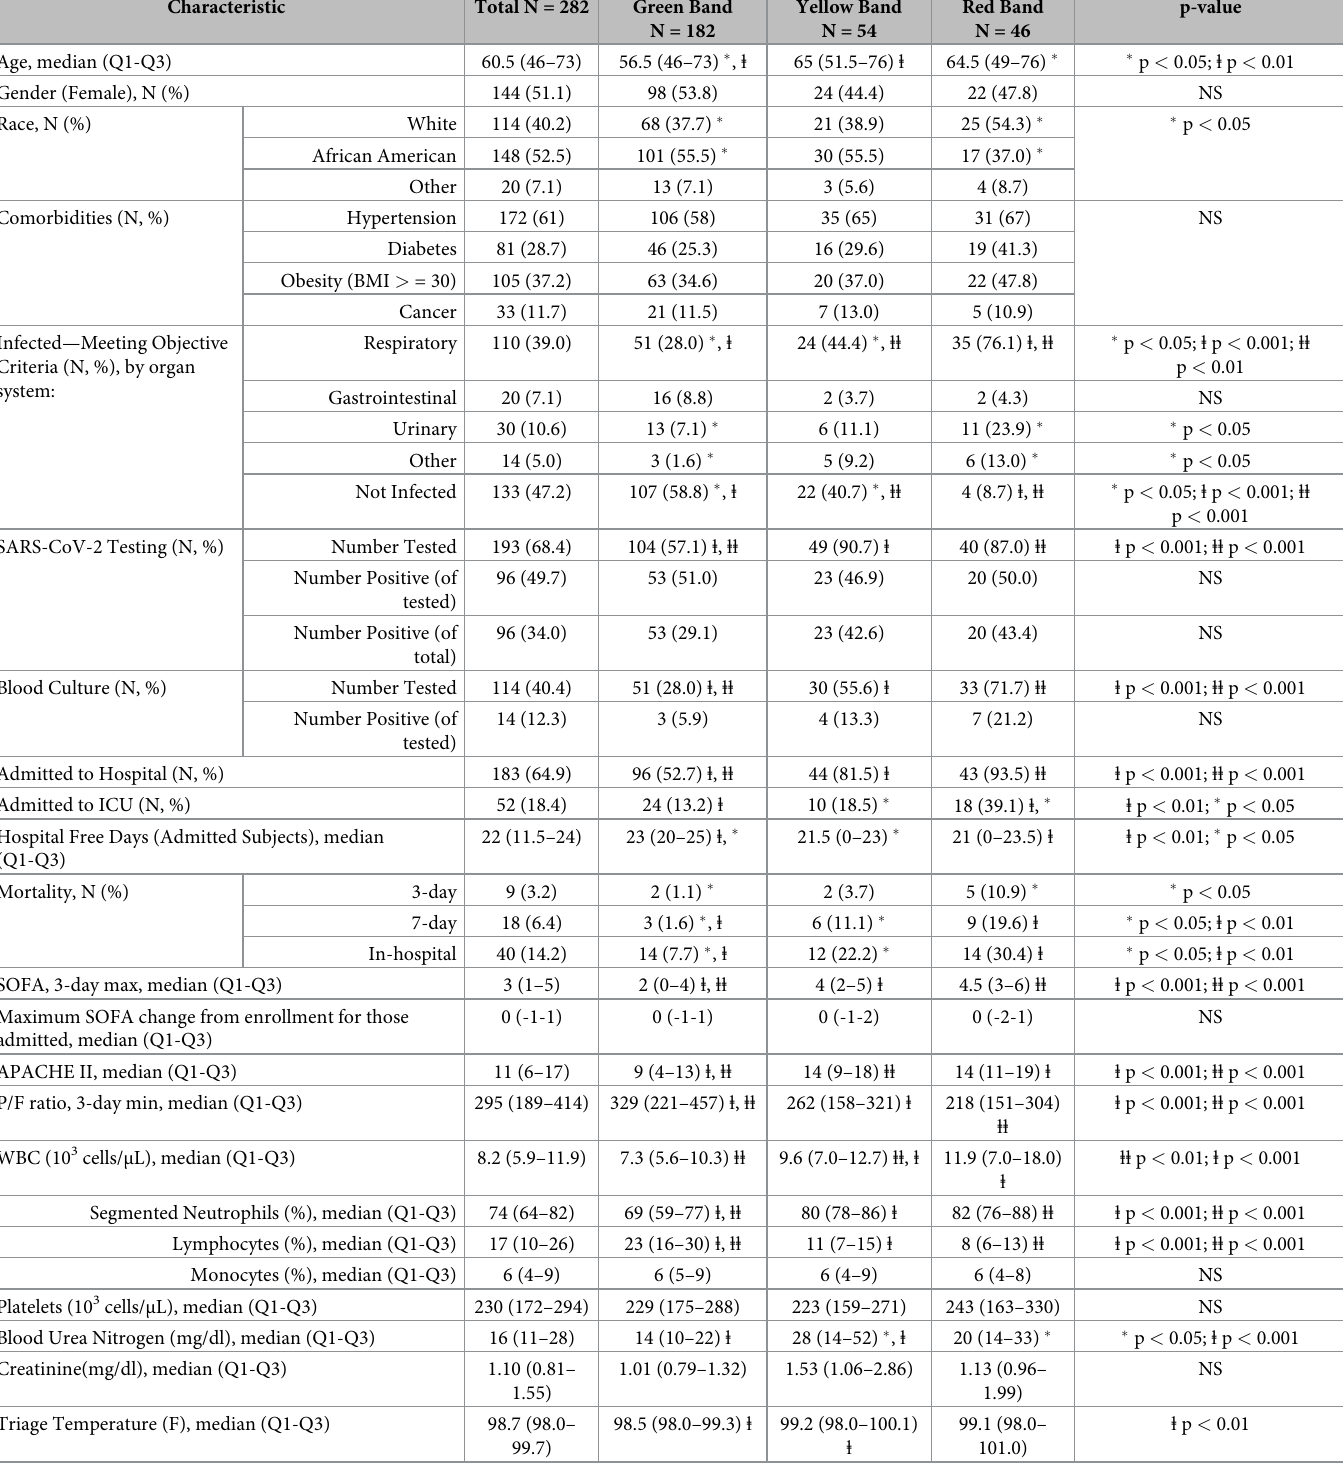
Table 1. Baseline characteristics and selected outcomes of all evaluable patients (total) as well as stratified by ISI interpretation